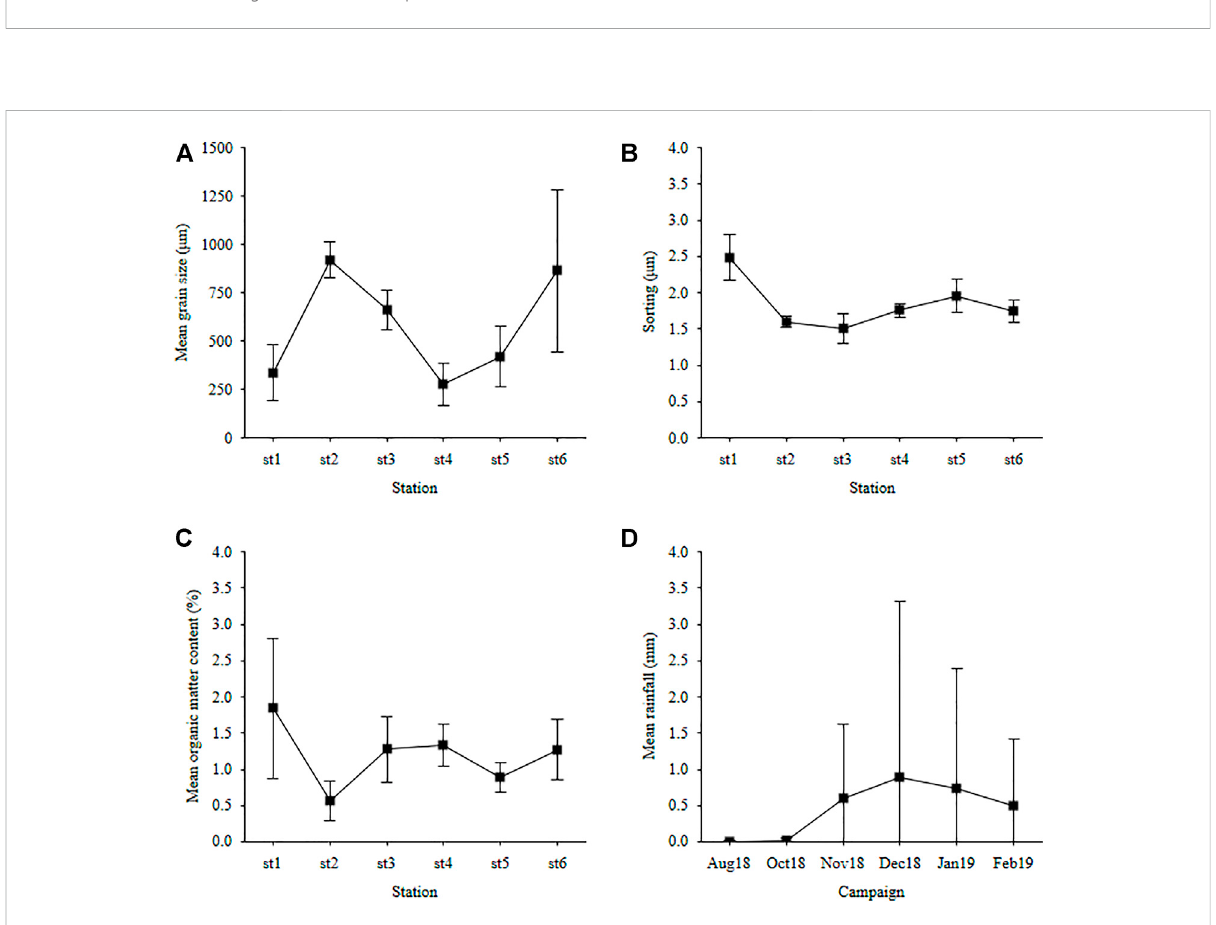
FIGURE 10 Spatialvariation of (A) meangrainsize (B) sedimentsortingand (C) organicmattercontent.Temporalvariation ofrainfall (D) .Dataisprovidedas mean ±